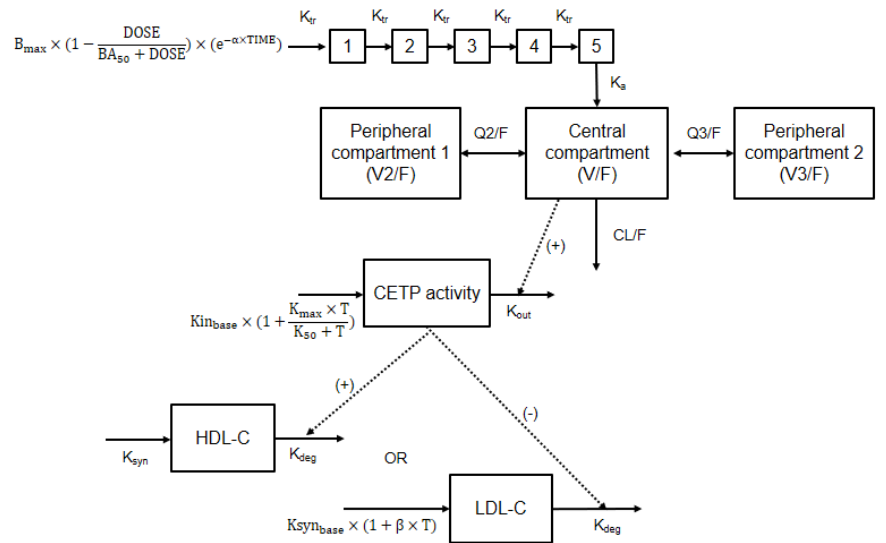
Figure 1. Schematic representation of the final pharmacokinetic and pharmacodynamics models for CETP inhibitor; The dose (DOSE) goes into the absorption compartment via transit